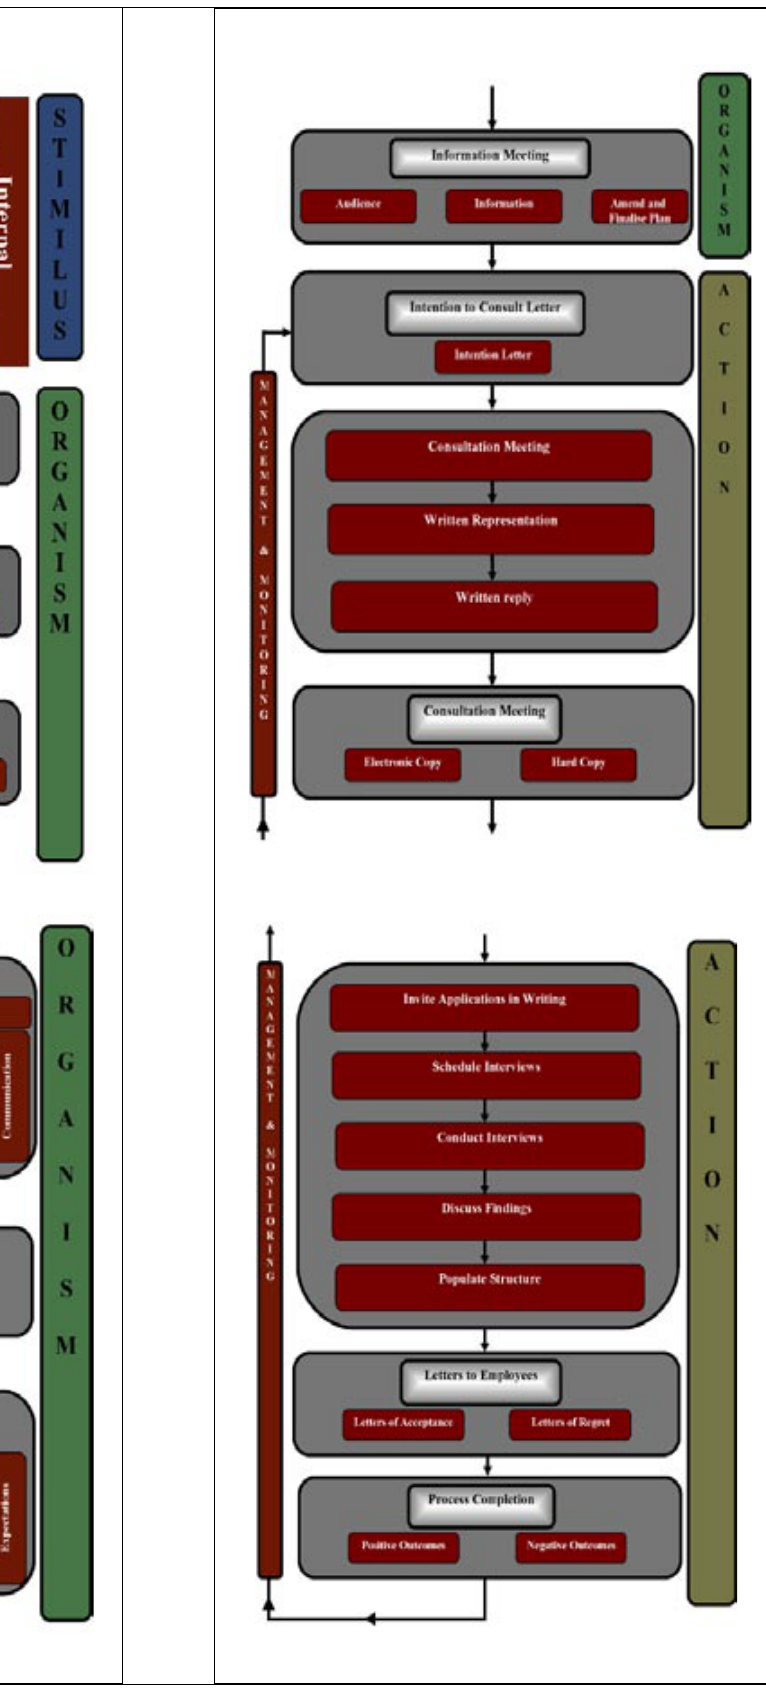
Figure 1 A model for organisation